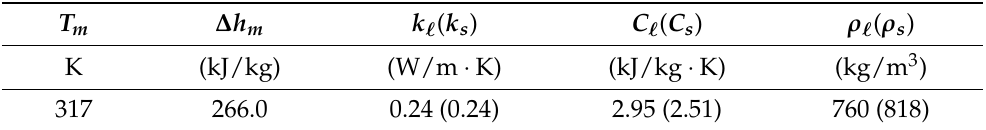
Table 1. Thermodynamic properties and liquid–solid saturation values of paraffin wax according to the authors of Ref.